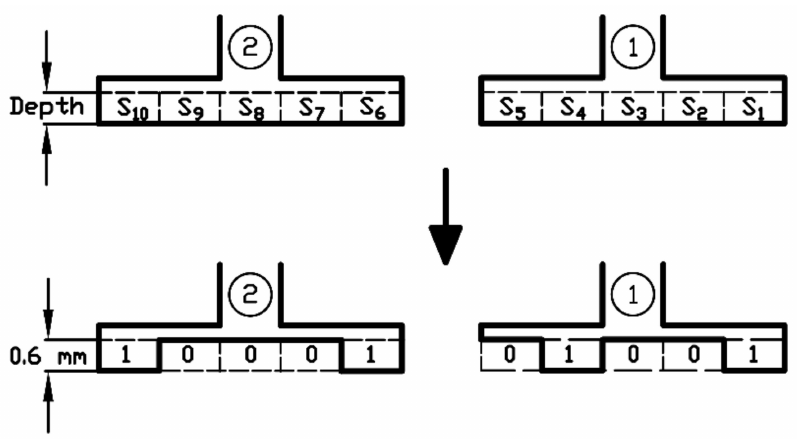
Figure 4. Example of two independent tooth tips discretized with a layer of 5 sub-teeth: N i = 2,